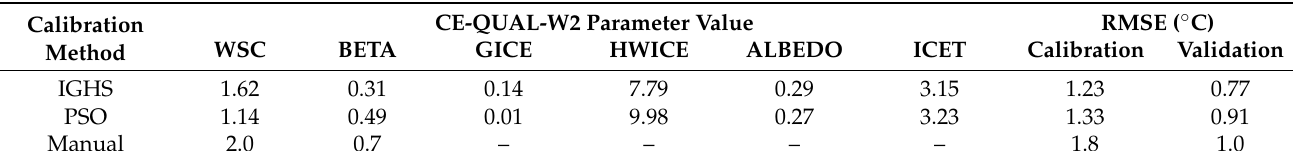
Table 2. The optimal values of the six CE-QUAL-W2 parameters calibrated by IGHS, PSO, and manually, and the calculated RMSE values of the simulated Devils Lake water temperatures for both calibration and validation periods.